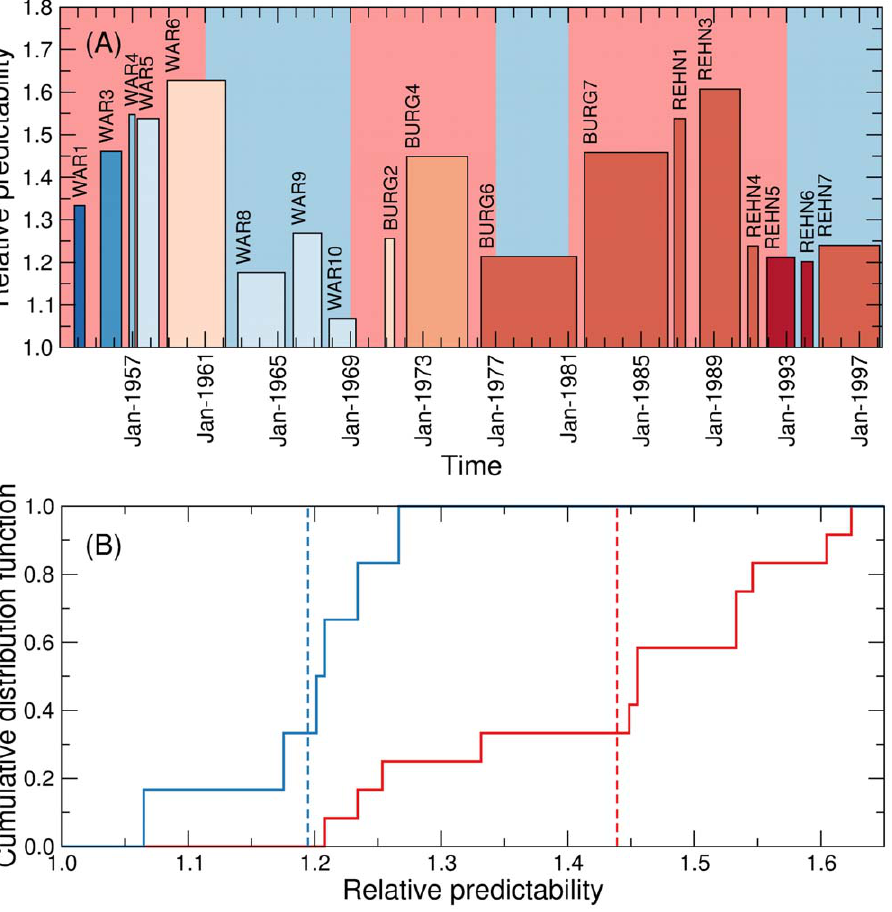
Figure 4. Relative court predictability. (A) The height of each bar indicates the average predictability of a court and its width the time span of the court. The color of the bar indicates the makeup of the court, with dark blue corresponding to a court with many Democrat–nominated justices, and dark red to a court with many Republican–nominated justices. (B) Cumulative distribution functions of the relative court predictability for courts that operated mostly under Democratic presidencies (blue) and Republican presidencies (red). The dashed lines indicate the means of the respective distributions.